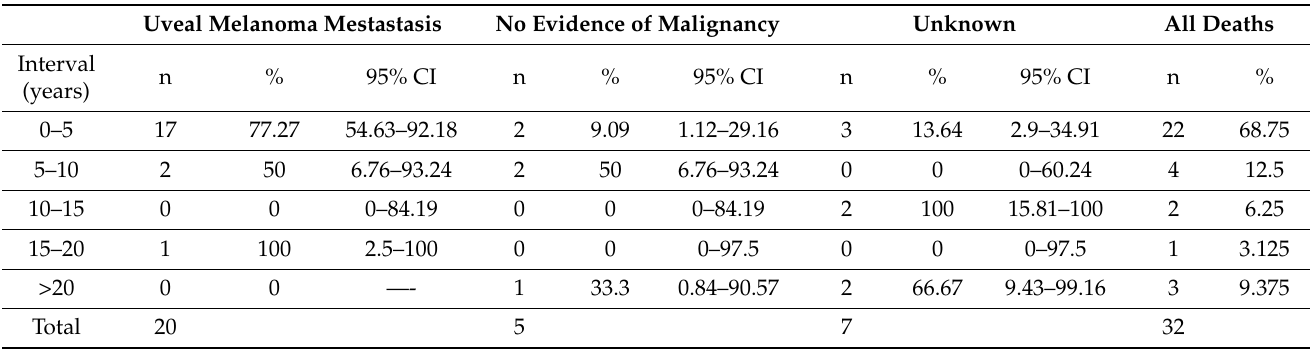
Table 2. Percentage of deaths due to specific causes relative to all deaths during follow-up. Uveal Melanoma Mestastasis No Evidence of Malignancy Unknown All